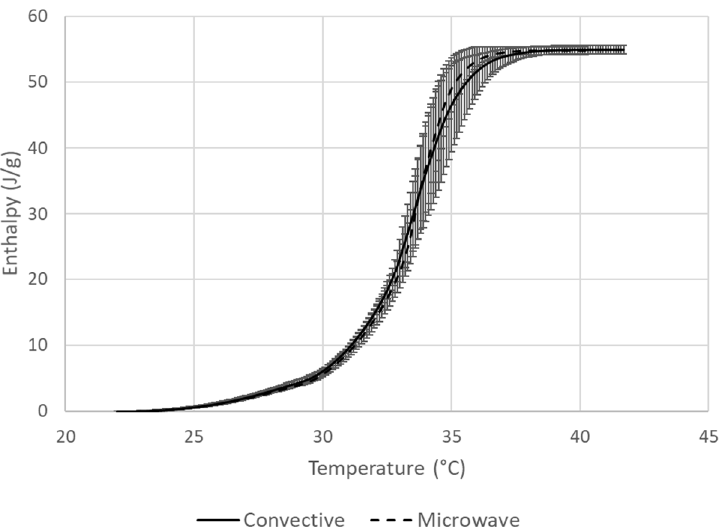
Figure 3. Melting enthalpy profile of chocolates produced from convective roasted cocoa beans and microwave roasted cocoa beans using differential scanning calorimetry ( n = 3).